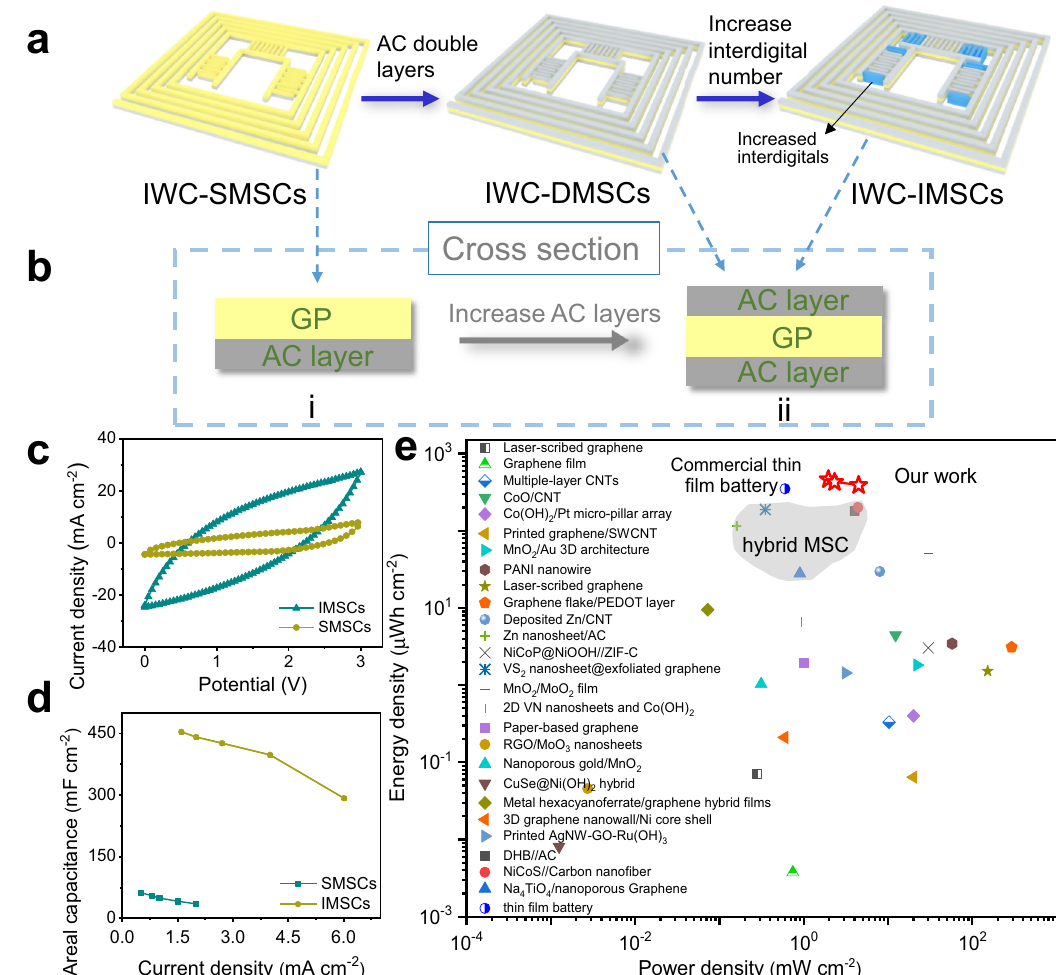
Fig. 3 Process and measurements of improving the performance of MSCs in a device. a Schematic diagrams of the procedure of optimizing MSCs in IWC-MSCs. b Change of cross-section of SMSCs, DMSCs, and IMSCs. c Comparison of CV curves under the scanning rate of 100 mV/s and ( d ) rate capacity curves of MSCs of SMSCs and IMSCs, respectively. e Ragone plots of the IMSCs compared with other reported